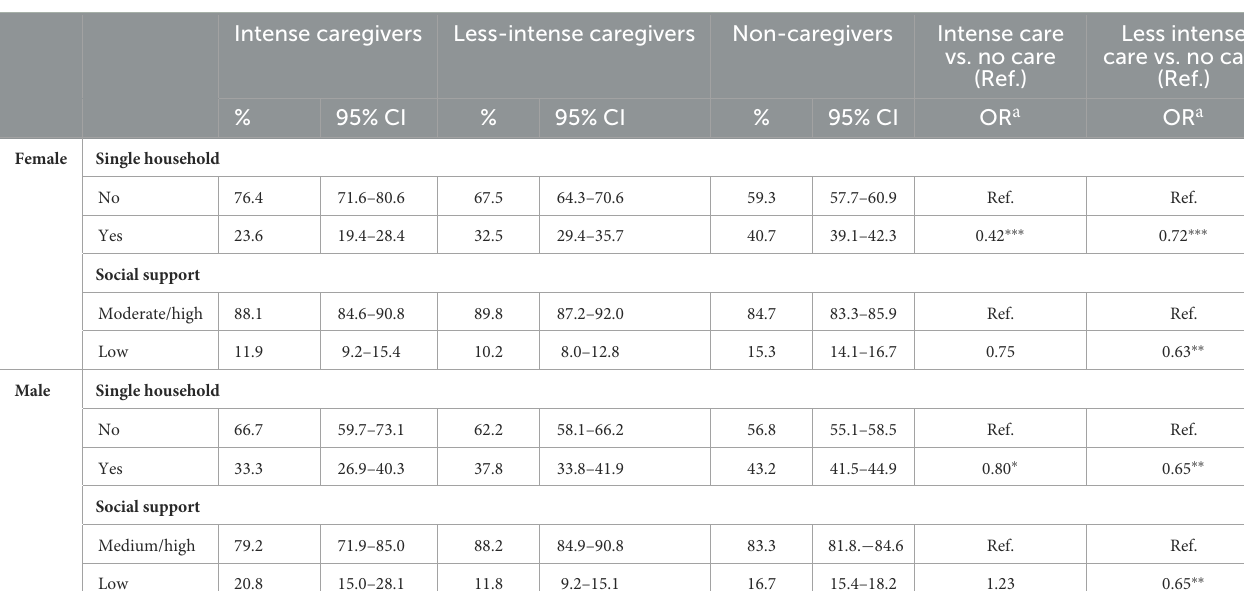
TABLE 5 Social risk factors of caregivers and non–caregivers by gender (weighted analyses). Intense caregivers Less-intense caregivers Non-caregivers Intense care